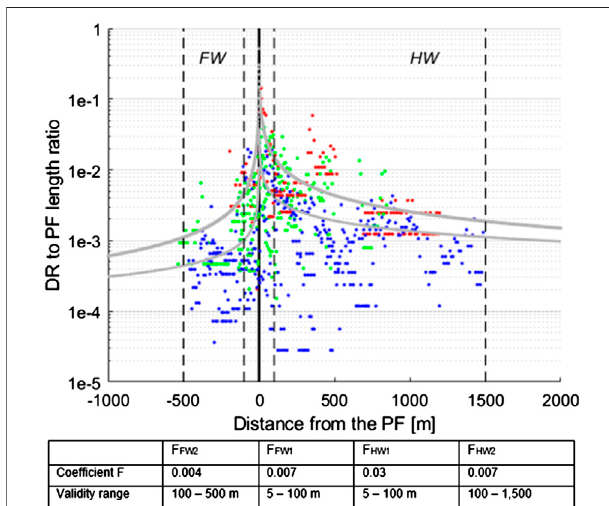
FIGURE 8 | Fraction of DRs lengths to PF lengths, and power fi t as a functionofdistancefromthePF:thicker fi ttomaximumvalue;thinner fi tto “ all ” values, and the fi xed values of coef fi cient F and their applicability range. The events in the database are grouped according to their magnitude as previously; M w 5 – 6 plotted in red, M w 6 – 7 in green, and M w 7 – 8 in blue. The dashed lines show the validity ranges in which the various coef fi cients F listed in the table are valid; the subscript of the coef fi cient F indicates the side on hanging wall (HW) or on footwall (FW) side, and order of the coef fi cient counted from the PF (1 or 2). Only simple type of DR considered (rank 2